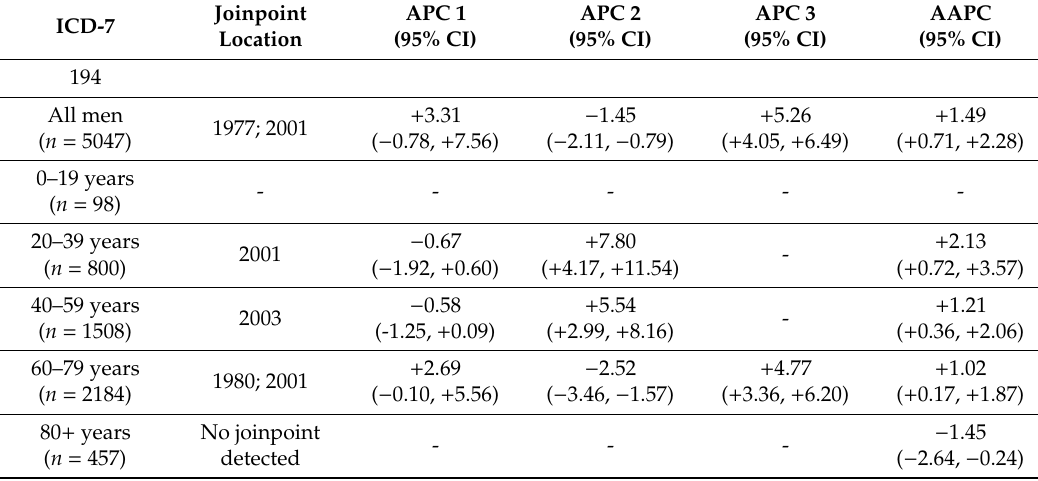
Table 2. Joinpoint regression analysis of thyroid cancer incidence in men in the Swedish Cancer Register 1970–2017. ICD-7 code 194 (https: // sdb.socialstyrelsen.se / if_can / val.aspx). APC = Annual Percentage Change (APC 1 = time from 1970 to first joinpoint; APC 2 = time from first joinpoint to 2017 or to second joinpoint; APC 3 = time from second joinpoint to 2017); AAPC = Average Annual Percentage Change.